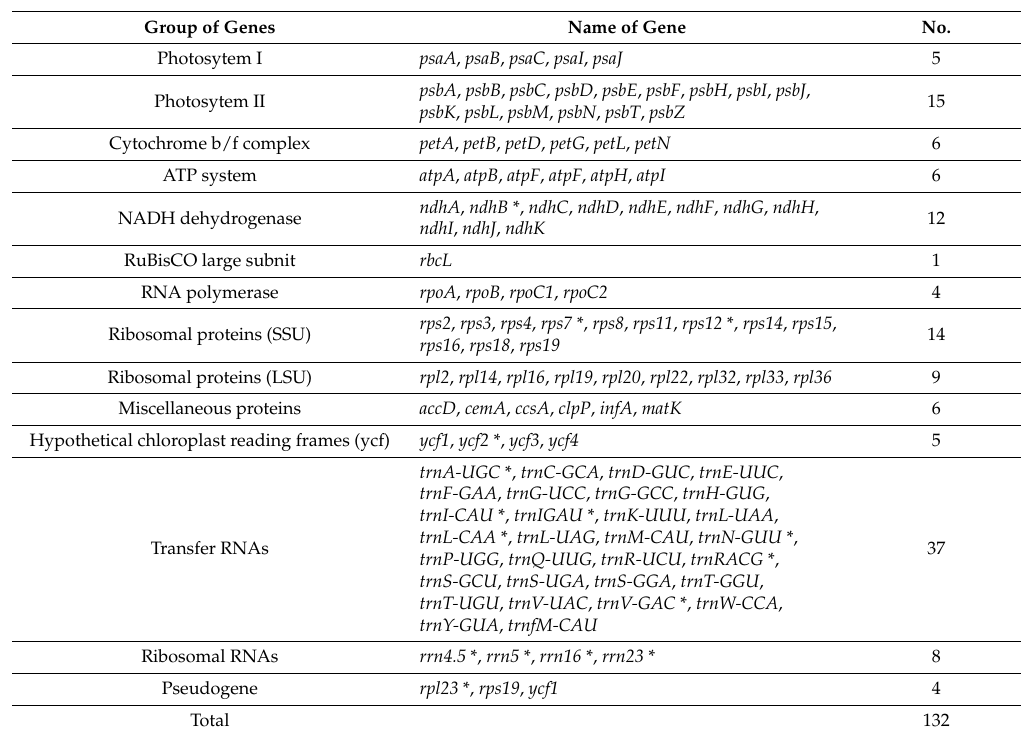
Table 2. Genes of the Talinum paniculatum ( Jacp ) Gaertn.